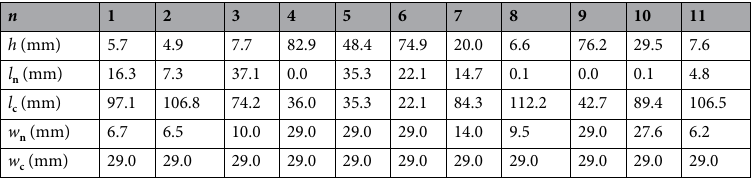
Table 4. Geometrical parameters used for the broadband metadiffuser using N different